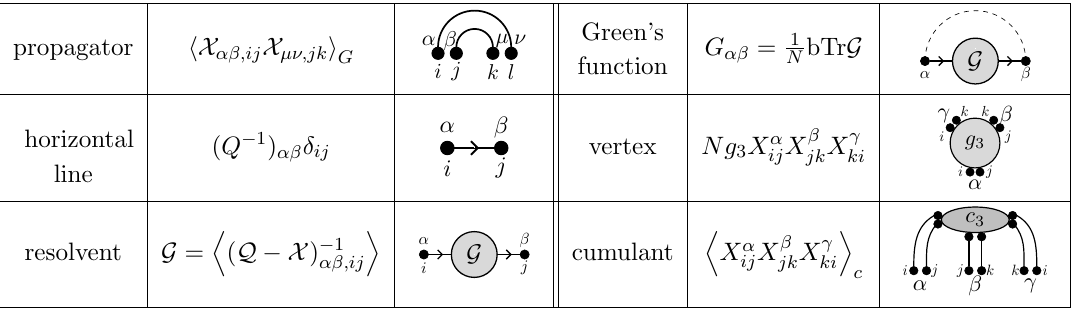
Table 1 . Diagrammatic representation of the basic expressions in the moment expansion of the resolvent. The propagator represents the averages with respect to the Gaussian potential (2.14). An exemplary vertex is drawn for the theory which contains the cubic interaction Ng 3 Tr X (cid:11) X (cid:12) X (cid:13) in the potential. A cumulant (dressed vertex) represents a sum over all connected diagrams connected to the baseline. Its structure in matrix indices (Latin letters) is the same as that of the vertex, because the propagators are the Kronecker deltas in this indices. The dashed line without arrows represent summation over Latin indices